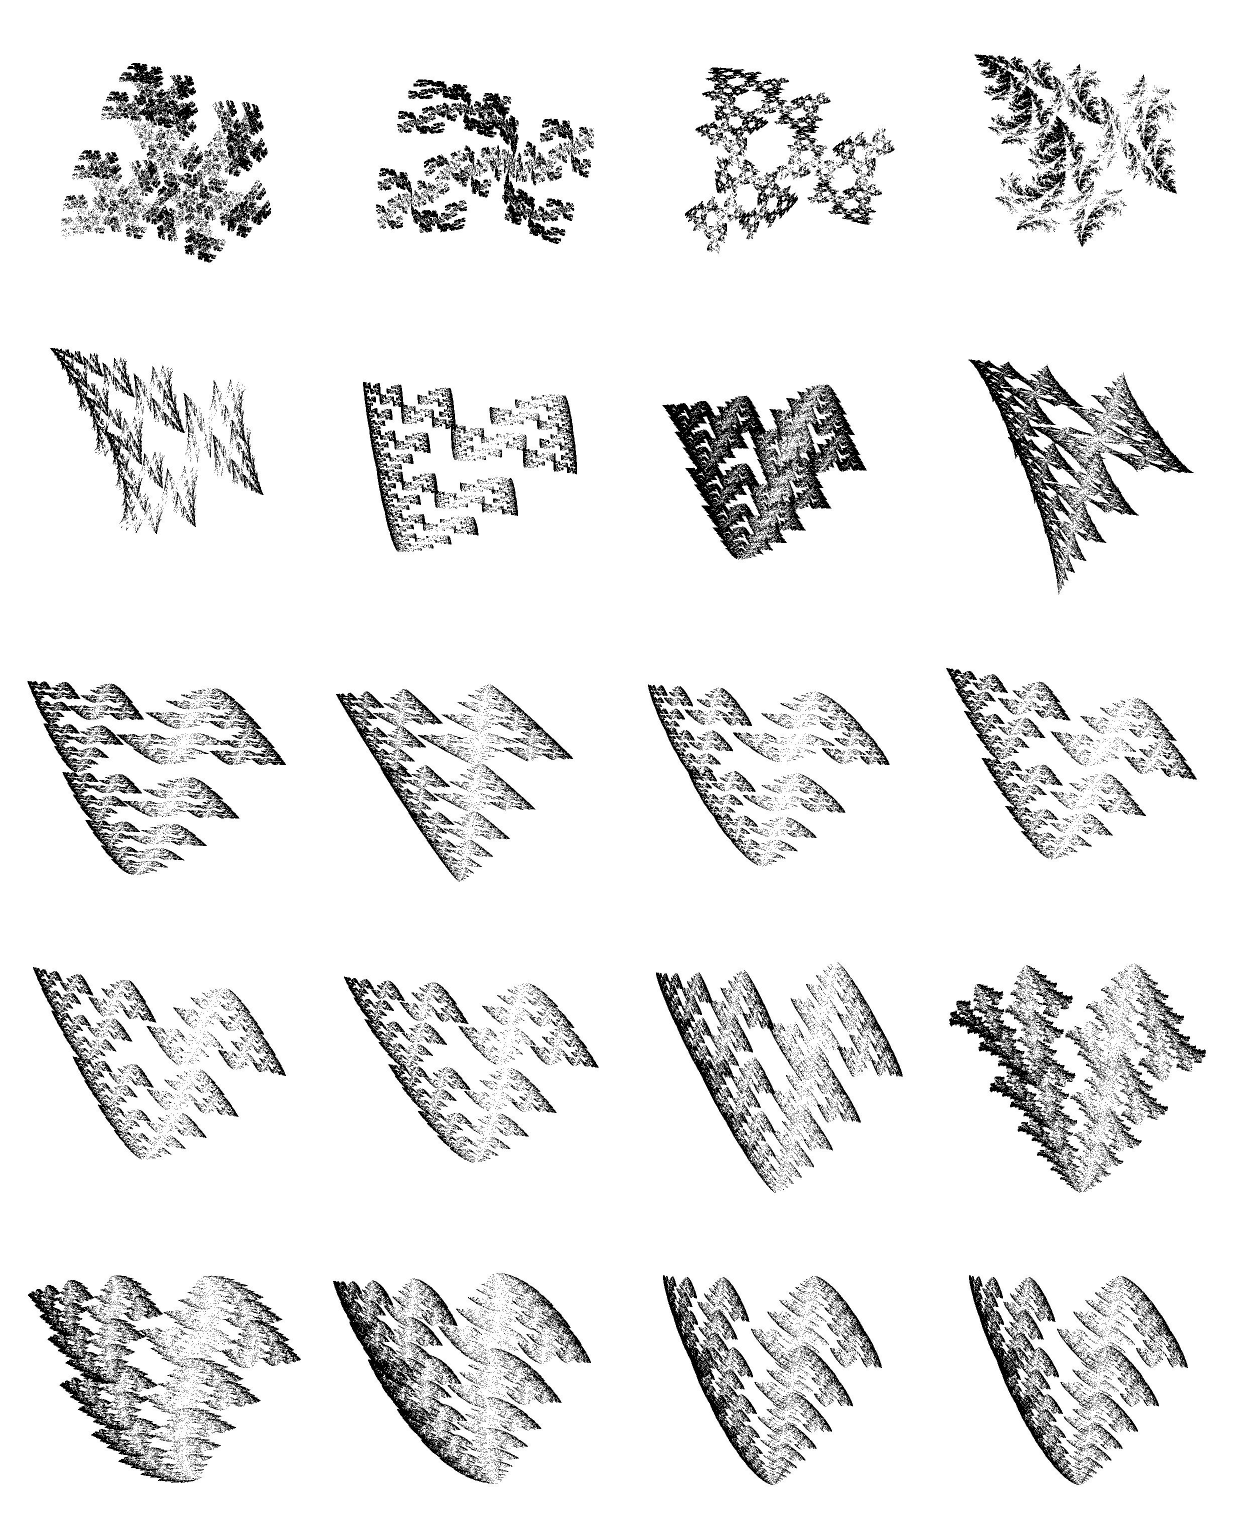
Figure 4. ( left – right , top – bottom ): Evolution of the reconstructed image for 0–380 iterations (step size, 20